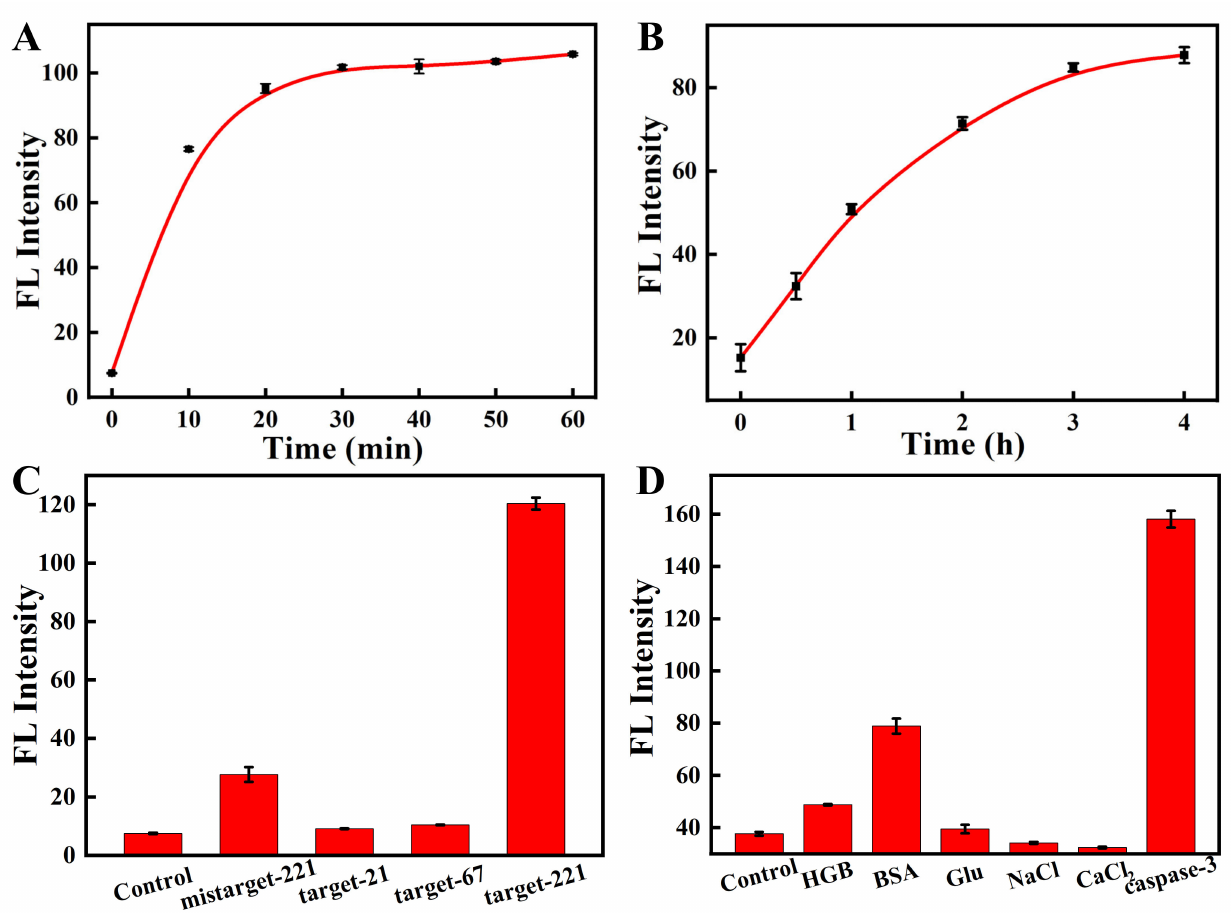
Figure 5. Kinetics of the nanosensor in the presence of target-221 ( A ) and caspase-3 ( B ). The specificity experiments of MB ( C ) and peptide ( D ) modified on the